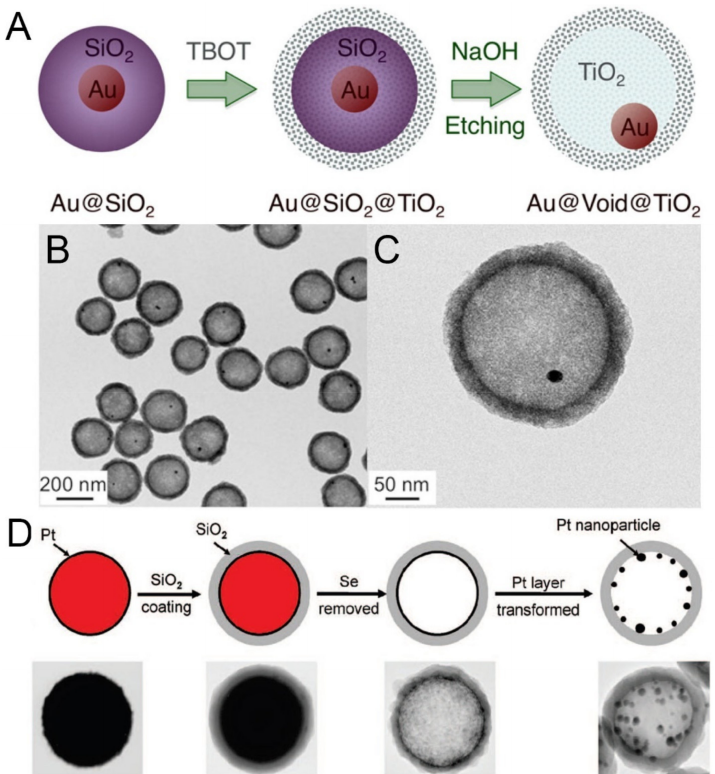
Figure 1. Templating approaches for yolk–shell nanostructures. ( A ) Synthetic scheme of Au@TiO 2 yolk–shell nanostructure by using SiO 2 as a sacrificial layer. ( B , C ) TEM images of the Au@TiO 2 yolk–shell after etching the SiO 2 layer. Reproduced with permission from [31]. Copyright Elsevier Ltd, 2016. ( D ) Decoration of interior surfaces in the SiO 2 hollow shell by exploiting amorphous Se colloids as a template. Reproduced with permission from [35]. Copyright American Chemical Society,